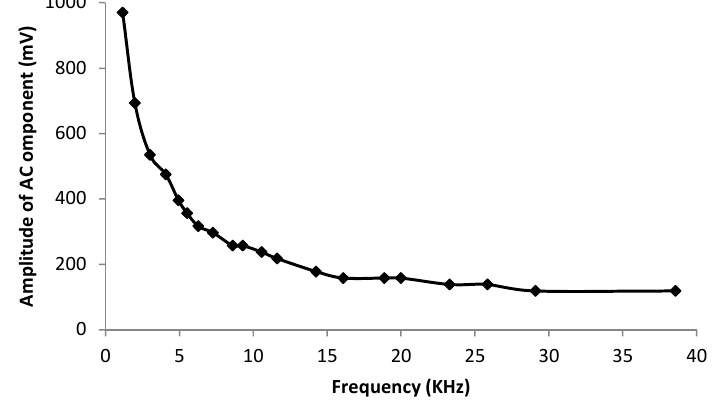
Figure 4. Indoor solar panel response to different frequencies.